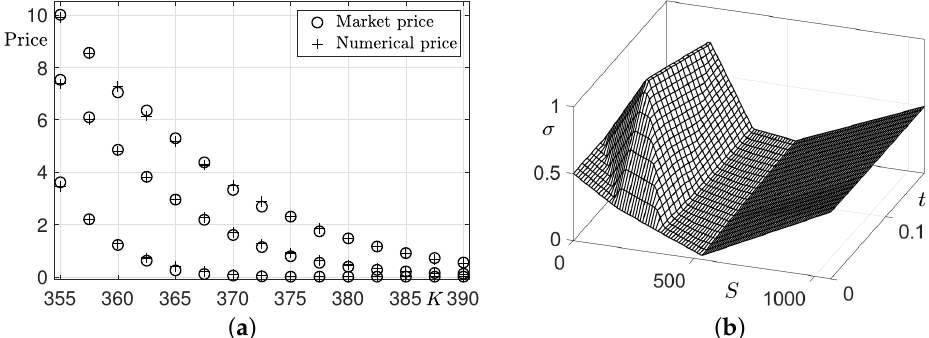
Figure 9. ( a ) Call option market and computed prices. ( b ) Reconstructed local volatility